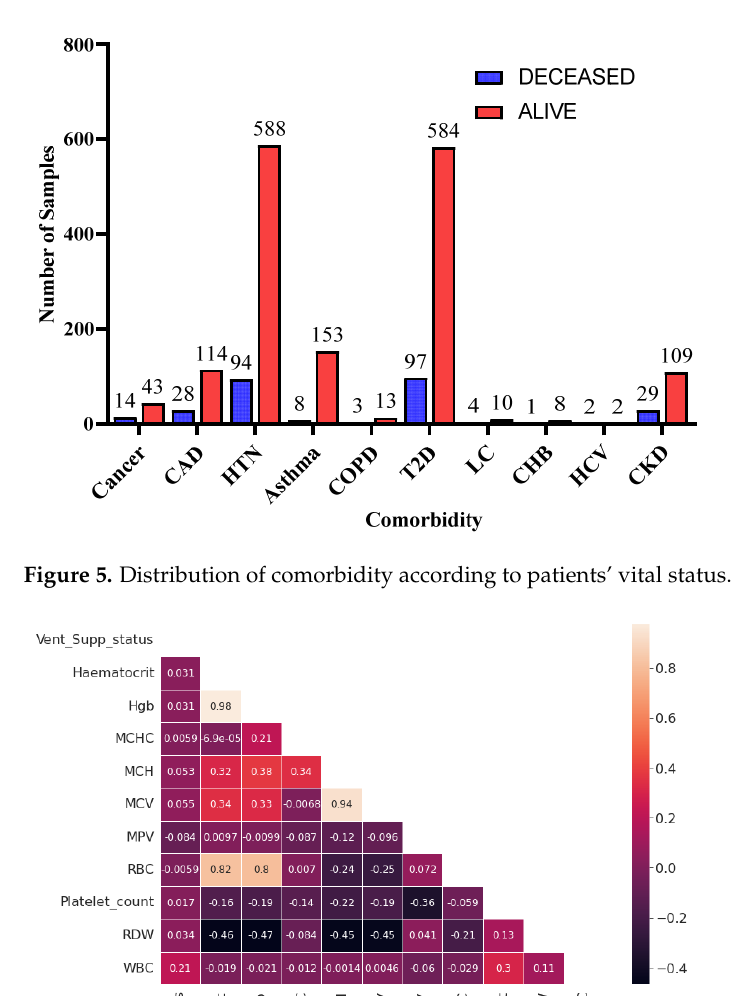
Figure 4. Distribution of comorbidity according to ventilator support cases.